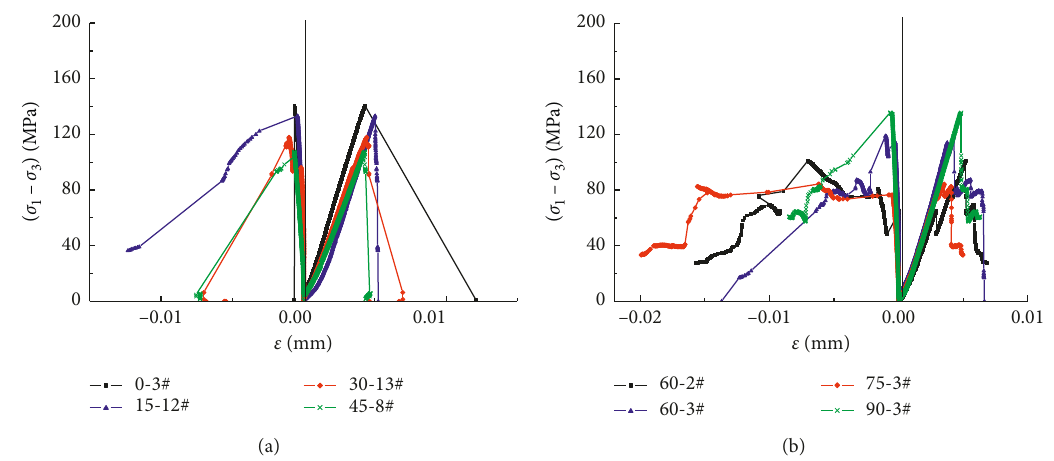
Figure 6: The stress-strain curves of the specimens: confining pressure of 0MPa.